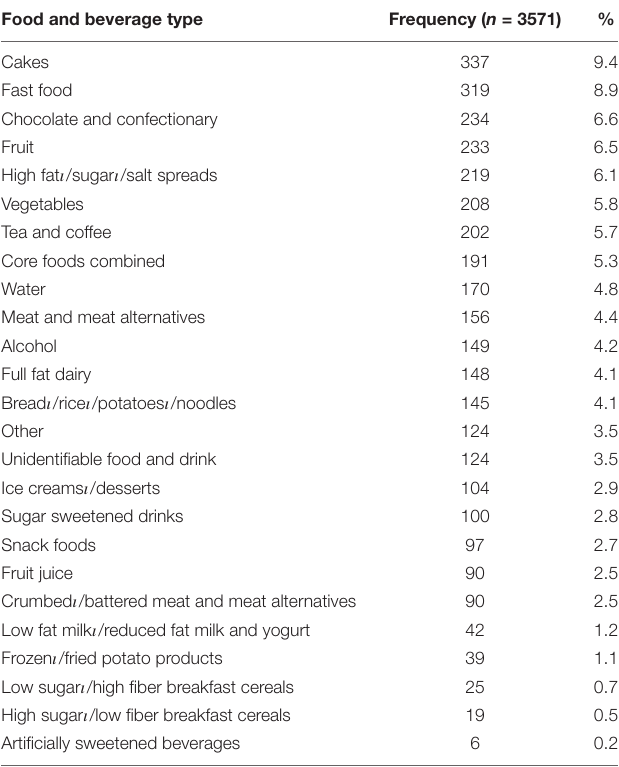
TABLE 2 | Food and beverage types ordered by frequency of appearance in influencer YouTube